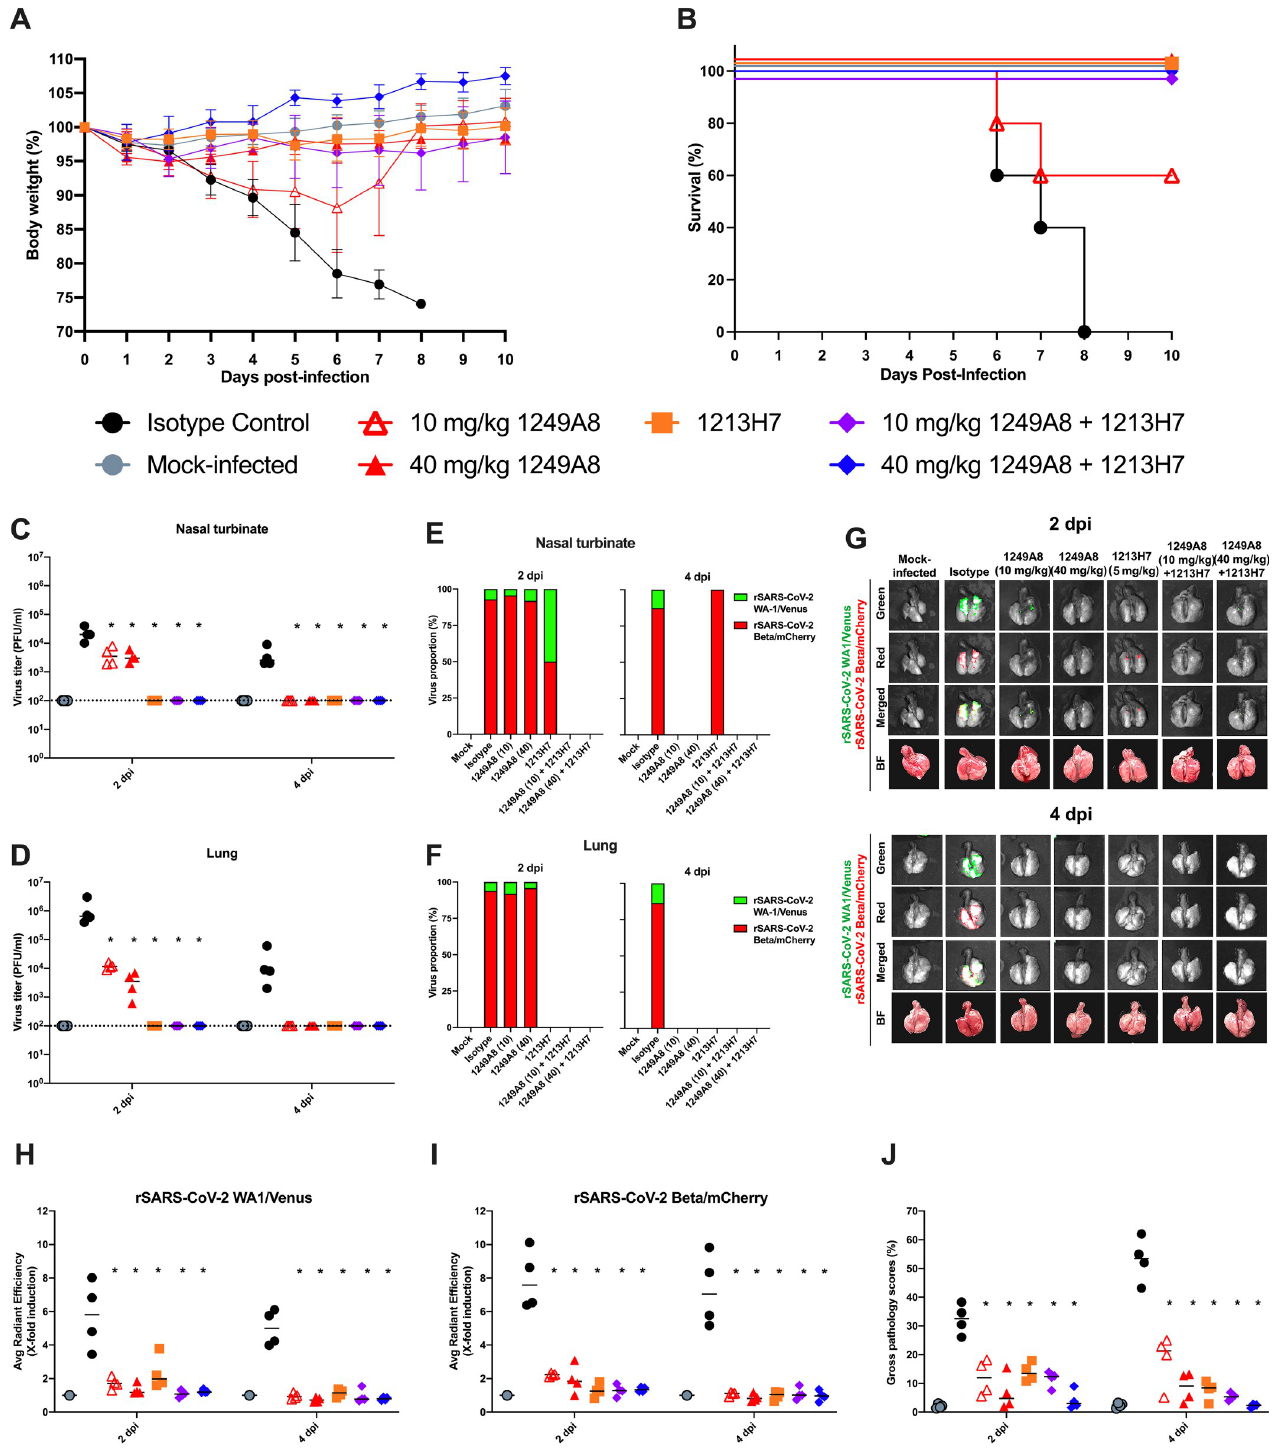
Fig 3. Prophylactic activity of 1249A8 hmAb against rSARS-CoV-2 WA1-Venus and rSARS-CoV-2 Beta-mCherry in K18 ACE2 transgenic mice model. Female K18 hACE2 transgenic mice were treated i.p. with 1249A8 (10 mg/kg or 40 mg/kg), 1213H7 (5 mg/kg), alone or in combination, or isotype control hmAb (40 mg/kg), followed by infection with both rSARS-CoV-2 Venus and rSARS-CoV-2 Beta/mCherry Beta. Body weight ( A ) and survival ( B ) were evaluated at the indicated days post-infection (n = 5 mice/group). Mice that loss > 25% of their body weight were humanely euthanized. Error bars represent standard deviations (SEM) of the mean for each group of mice. Viral titers in the nasal turbinate ( C ) and lung ( D ) at 2 and 4 DPI were determined by plaque